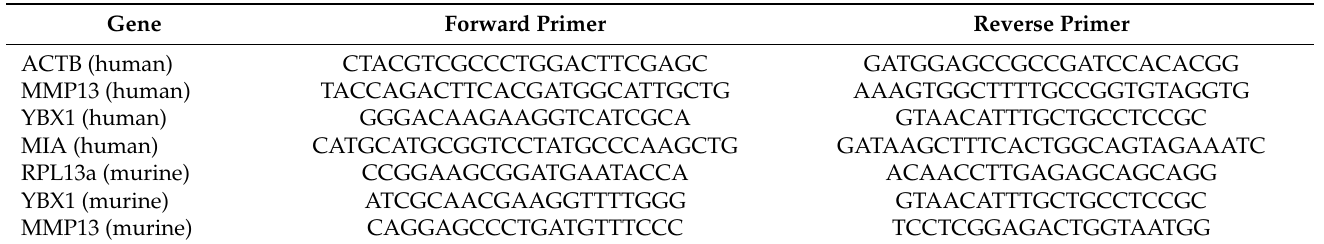
Table 1. Oligonucleotides used for real-time